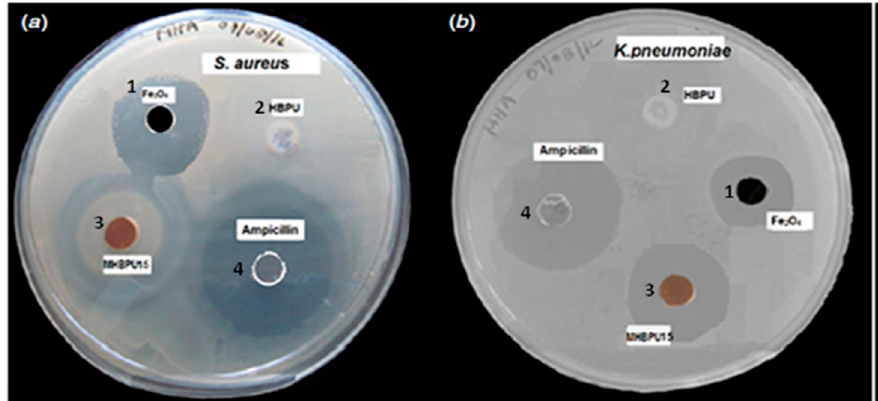
Figure 13. Inhibition zone showing the antibacterial activity against of S. aureus ( a ) and K. pneumoniae ( b ), respectively, of Fe 3 O 4 ( 1 ), sunflower oil derived-polyurethane ( 2 ), the corresponding nanocomposite with 15 wt % loading ( 3 ), and the control ( 4 ). Adapted from [48], copyright 2013, with permission from IOP publishing.